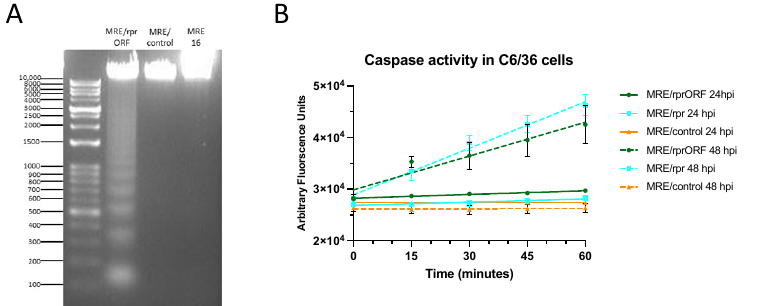
Figure 3. MRE/rprORF causes apoptosis in C6/36 cells. ( A ) C6/36 cells were infected with MRE/rprORF, MRE/control, or 5 ′ dsMRE16ic (labeled MRE16). After 48 h, the cells were collected, DNA was extracted, and run on an agarose gel containing ethidium bromide. ( B ) Cells infected with MRE/rprORF, MRE/rpr, or MRE/control were collected and lysed at 24 and 48 hpi. Caspase activity from these cell lysates was measured by examining their ability to cleave the fluorogenic substrate Ac-DEVD-AFC. Fluorescence measurements were taken every 15 min for 1 h. Three biological replicates were performed. The data were plotted using simple linear regression. Error bars indicate SEM.